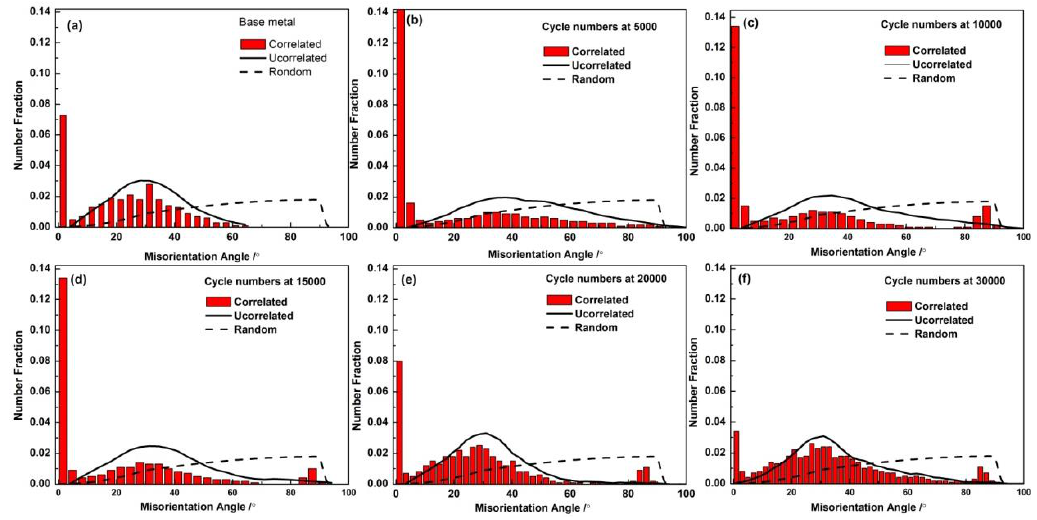
Figure 4. Misorientation distributions in AZ31B magnesium alloy: ( a ) as-received metal; ( b ) cycles at 5000; ( c ) cycles at 10,000; ( d ) cycles at 15,000; ( e ) cycles at 20,000; ( f ) cycles at 30,000.